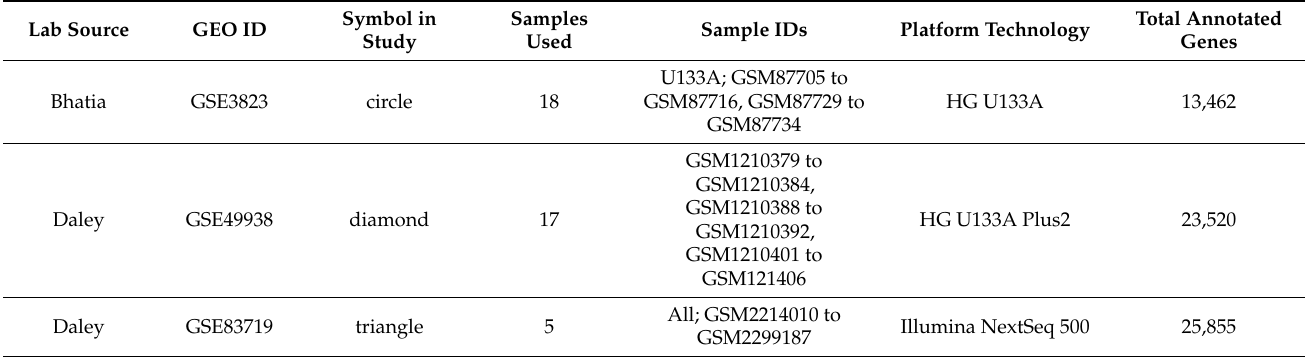
Table 6. Gene expression sample